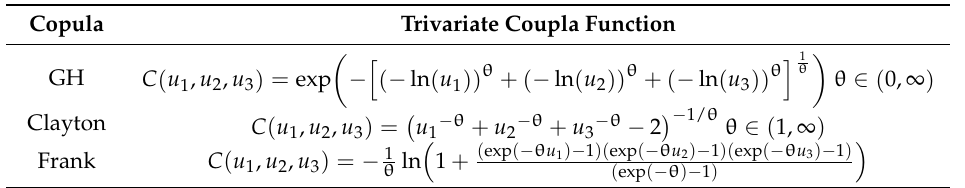
Table 1. Common Archimedean Copula functions